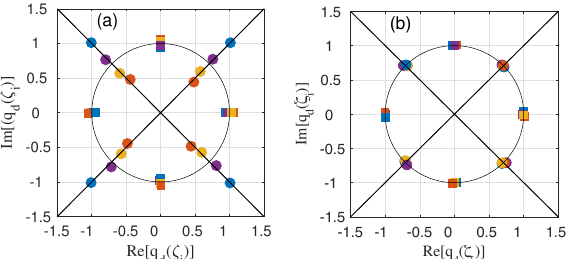
Figure A1. Constellations recovered at the receiver after 1600 km of propagation distance with the Raman effect and 10.25 dBm launch power. ( a ) Results of the received constellations without using any initial compensation. The dots with different colors show all the constellations that arise from the pattern dependence due to the Raman effect. ( b ) Results of the received constellations with the use of a pre-equalizer technique.